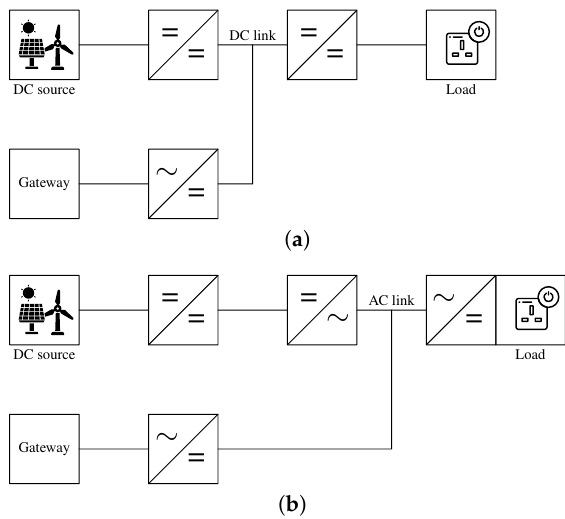
Figure 2. General block diagram for ( a ) DC and ( b ) AC